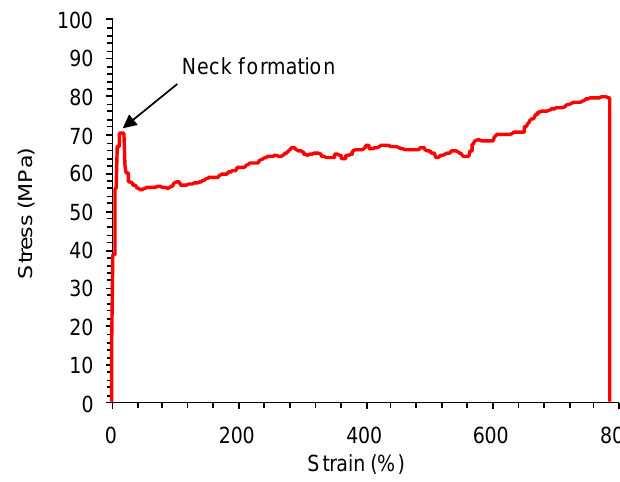
Figure 2. Stress–strain curve for polymer P14